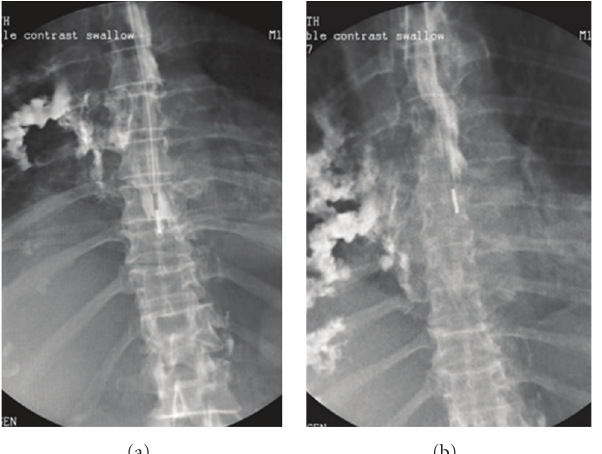
Figure 39: Two images from a water-soluble contrast swallow showing an esophageal perforation from an NGT in this case with esophageal varices.